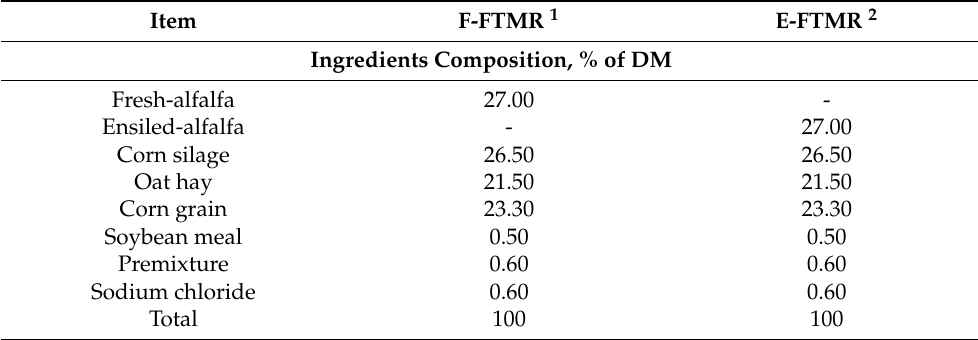
Table 1. Ingredients and proportions of the fresh-alfalfa and ensiled-alfalfa fermented total mixed ratio